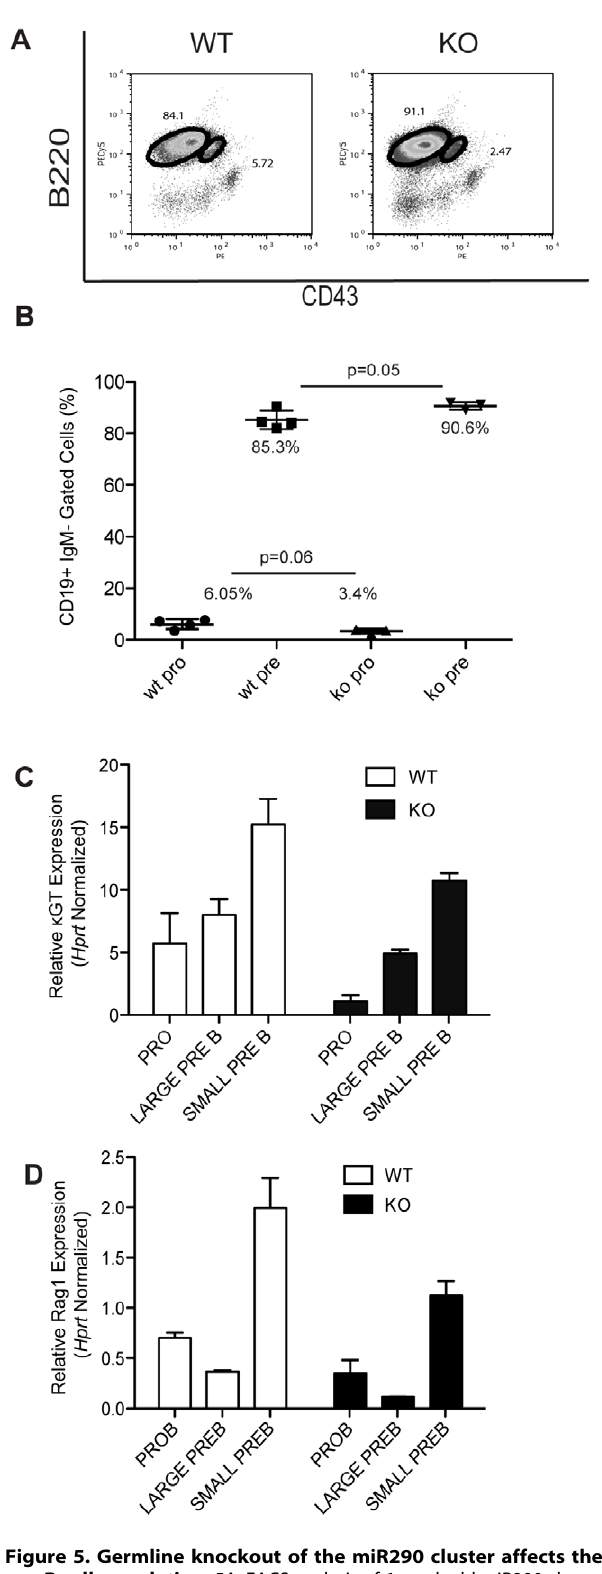
Figure 5. Germline knockout of the miR290 cluster affects the pre-B cell population. 5A. FACS analysis of 6 week old miR290 cluster knockout or wild-type mice. FACS plot reflects CD19 enriched cells gated on IgM negative cells. B220 + , CD43 + correspond to pro-B cells and B220 + , CD43 2 correspond to pre-B cells.; WT: pro-B, 5.72%, pre-B 84.1%; KO: pro-B, 2.47%, pre-B 91.1%. This experiment represents one of four independent experiments. Each experiment was with at least one